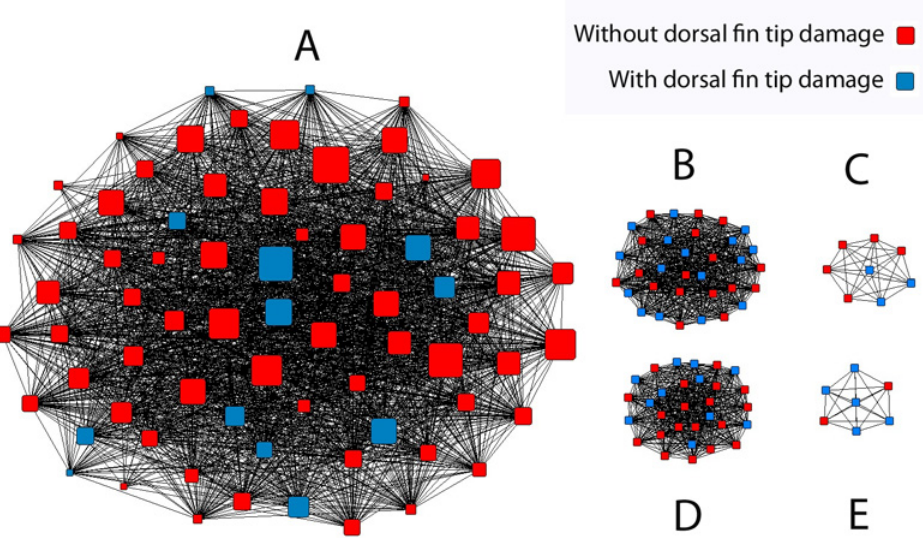
Fig 4. Social network analysis: sociogram of permanently marked individuals. Five social clusters (A-E), as identified by the social network analysis of associations of permanently marked bottlenose dolphins. Each symbol represents one individual, with the size of the symbols corresponding to the number of sightings of each individual (range: 1 – 18 sightings per individual). Blue squares represent individuals with typical scarring to the tip of the dorsal fin. Individuals without dorsal fin tip damage are represented by red squares. Black lines represent associations between individuals. The network composition has been manually adjusted to enhance the visualization of the separate